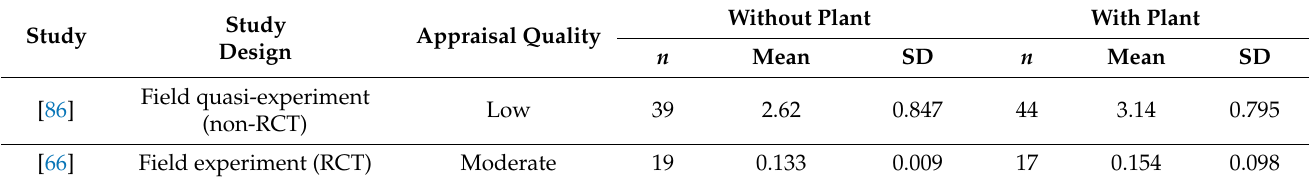
Table 16. Original data of the studies examining the influence of indoor plants on academic achievement.